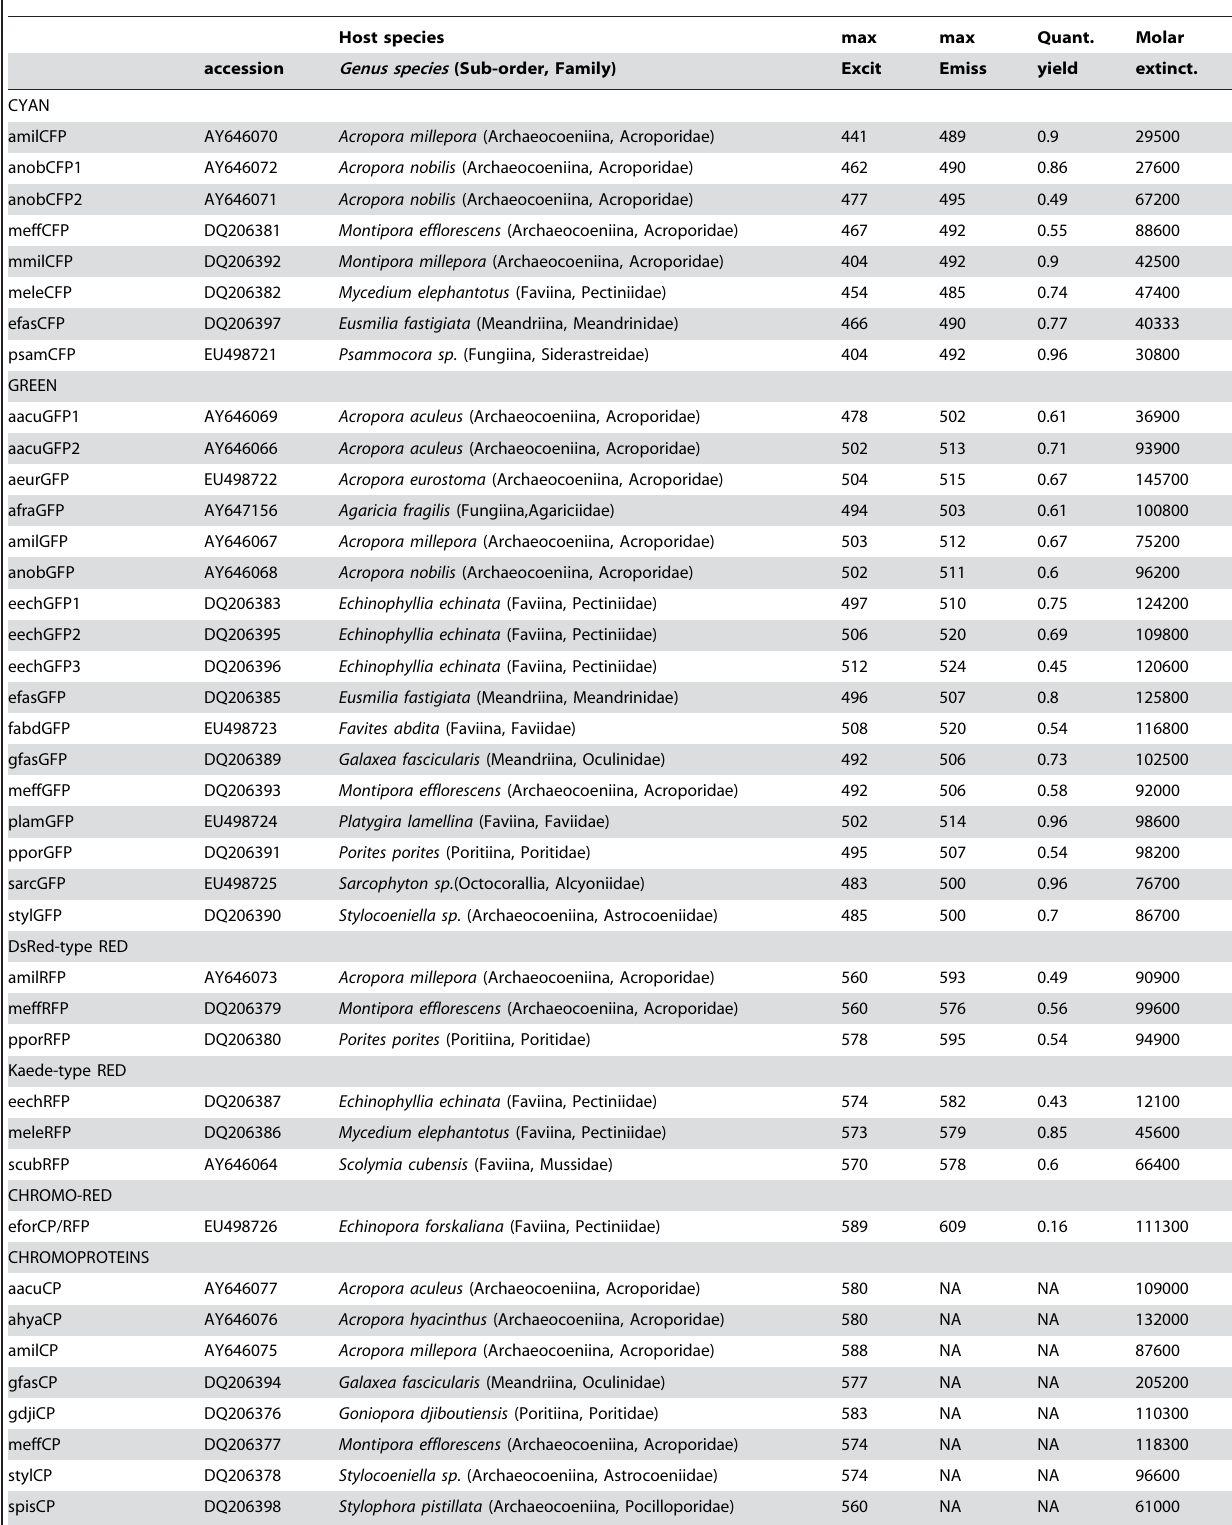
Table 1. Names, origins and spectroscopic characteristics of the newly cloned proteins.